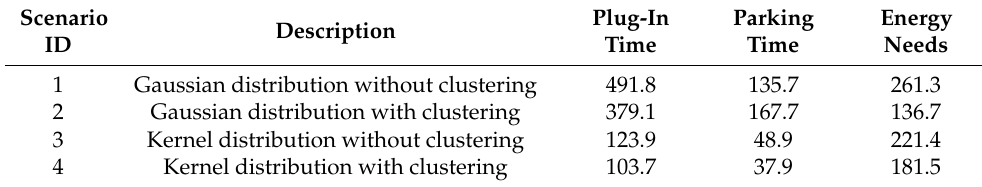
Table 3. Chi-square distance evaluation for different scenarios.